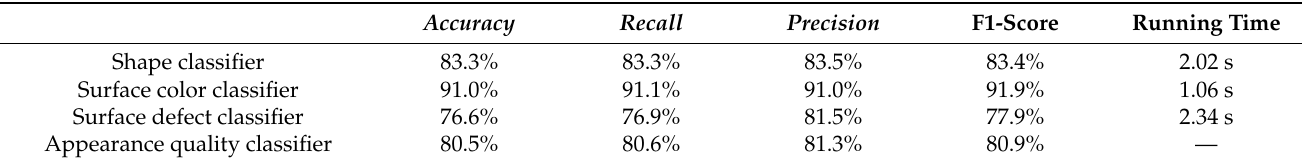
Table 5. Classification performance of the four classifiers.